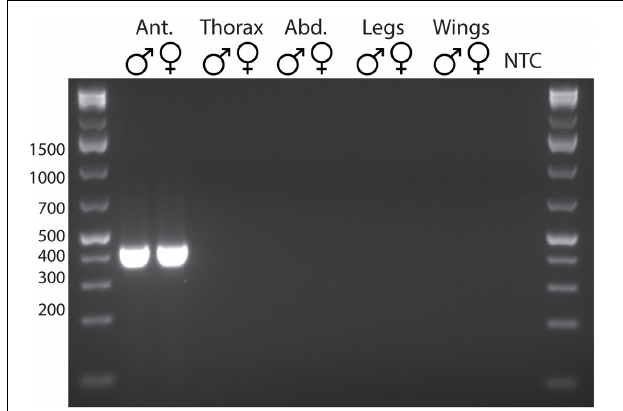
FIGURE 2 | Reverse transcription PCR showing antennal specific expression of C. pomonella OR3 in both sexes. Ant., antennae, Abd., abdomen, NTC, no template